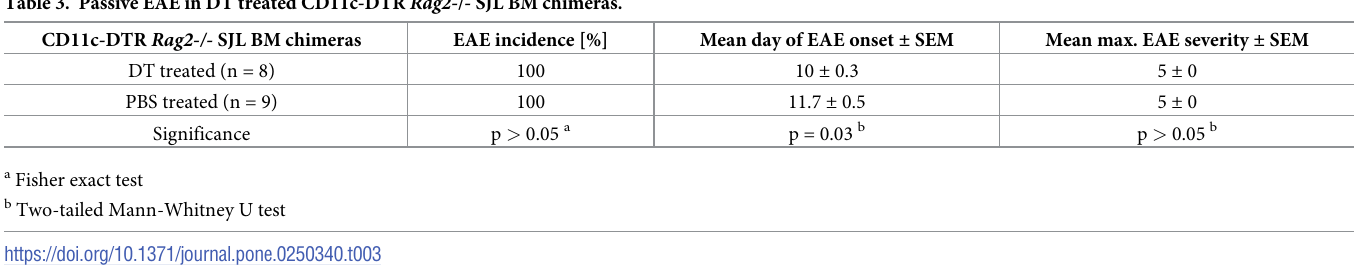
increased in diseased control mice (81.9% ± 9%; mean frequency ± SEM) but statistically not different to that in DT treated recipient mice (p > 0.05). Collectively, these results demonstrate that na ï ve PLP-specific CD4 + T cells were primed by endogenous autoantigen even in the absence of DCs in DT treated CD11c-DTR R ag2 -/- BM chimeric mice, resulting in accelerated onset of severe EAE. These findings indicate that DCs were not required for presenting autoantigen to PLP-specific CD4 + T cells, and that non-DCs compensated for the lack of DCs by efficiently promoting encephalitogenic T cell responses. The data further show that DC ablation in DT treated CD11c-DTR R ag2 -/- BM chimeric mice led to an acceleration of EAE onset, which was conceivably due to the loss of tolerogenic DCs.